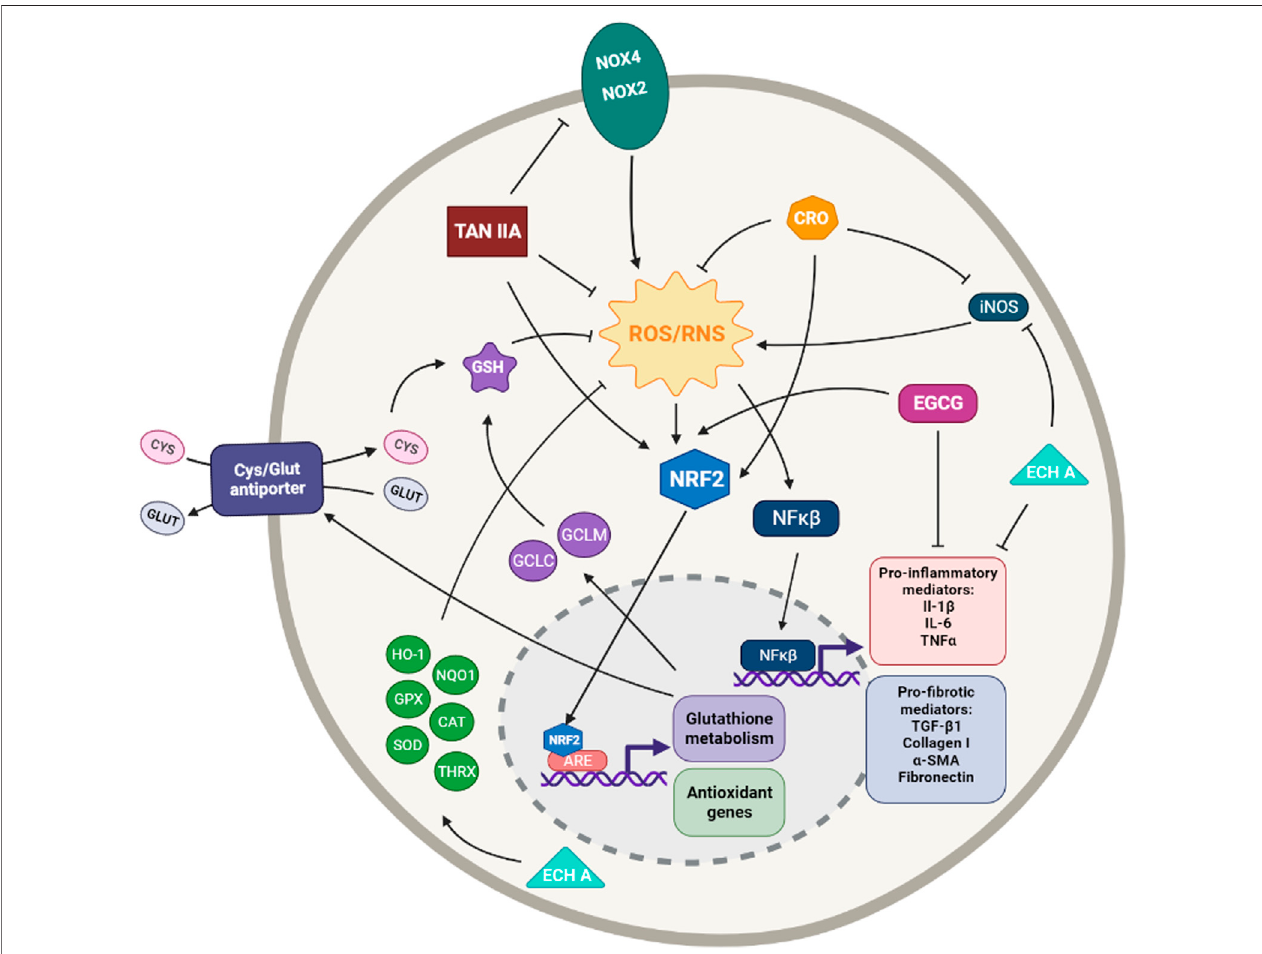
FIGURE 3 | Simpli fi ed diagram of the principal molecular mechanisms of the antioxidant enhancers Epigallocatechin (EGCG), Tanshinone IIA (TAN IIA), Crocin (CRO)andEchinochromeA(ECHA). α SMA:alphasmoothmuscleactin;ARE:antioxidantresponsiveelement;CAT:catalase;CYS:cysteine;GCLC:glutamatecysteine ligasecatalyticsubunit;GCLM:glutamatecysteineligasemodi fi ersubunit;GLUT:glutamate;GPX:glutathioneperoxidase;GSH:glutathione;HO-1:hemeoxygenase1; IL-1 β : interleuquina 1beta; IL-6: interleuquina 6; iNOS: inducible nitrogen oxide synthase; NF κβ : nuclear factor kappa beta; NOX1,2,4: NADPH oxidases; NQO1: NAD(P)H:quinone oxidoreductase 1; NRF2: nuclear factor erythroid 2-related factor 2; ROS/RNS: reactive oxygen species/reactive nitrogen species; TGF- β 1: transforming growth factor beta 1; TNF α : tumoral necrosis factor alpha; SIRT: sirtuine 1; SOD: supeoxide dismutase Created with